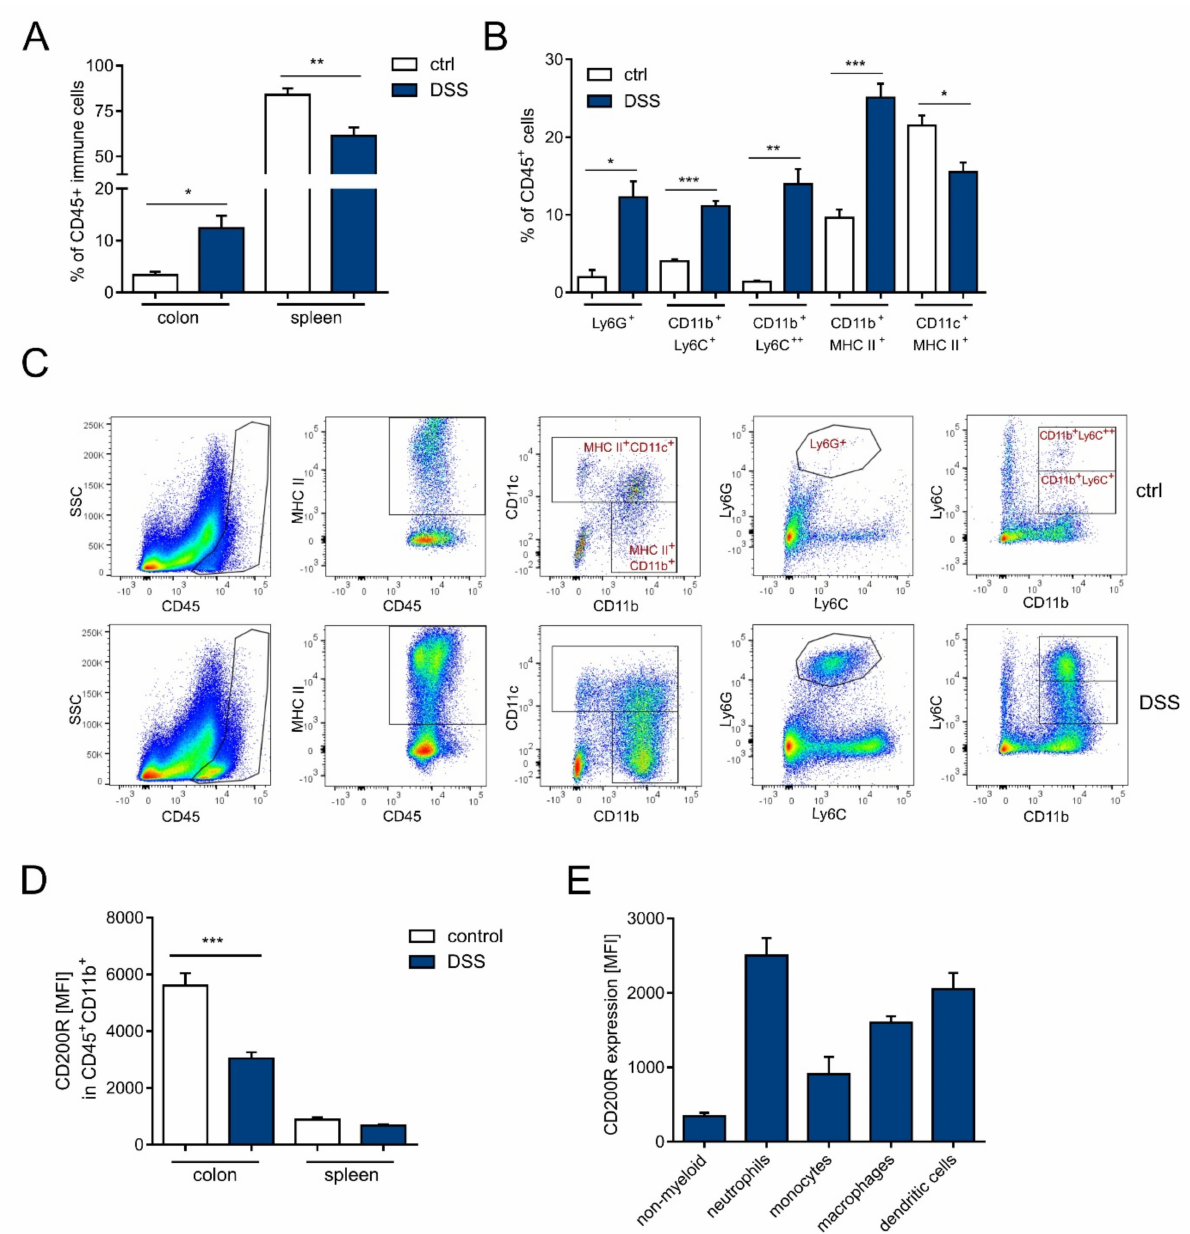
Figure 2. Analysis of immune cell infiltration in colon and spleen during DSS-induced inflammation. ( A ) Frequency of immune cells (CD45 + ) in colon and spleen in DSS-treated and control mice, n = 4–7; ( B ) Percentage of neutrophils (Ly6G + ), monocytes (CD11b + Ly6C + and CD11b + Ly6C ++ ), macrophages (CD11b + CD11c − MHC-II + ), and dendritic cells (CD11b − CD11c + MHC-II + ) in CD45 + immune cells in colons of DSS-treated and control mice, n = 3–8; ( C ) Representative dot plots of myeloid cell populations in colons isolated from DSS-treated and control mice; ( D ) Expression of CD200R in CD45 + CD11b + cells isolated from colons and spleens of DSS-treated or control mice, n = 4–7; ( E ) Expression of CD200R in colonic populations of immune cells, n = 6. All results are expressed as mean ± SEM. Significant differences were calculated using Student’s t -test * p < 0.05. ** p < 0.01. *** p <0.001 compared with controls. Data shown are combined from two independent experiments. MFI: mean fluorescence